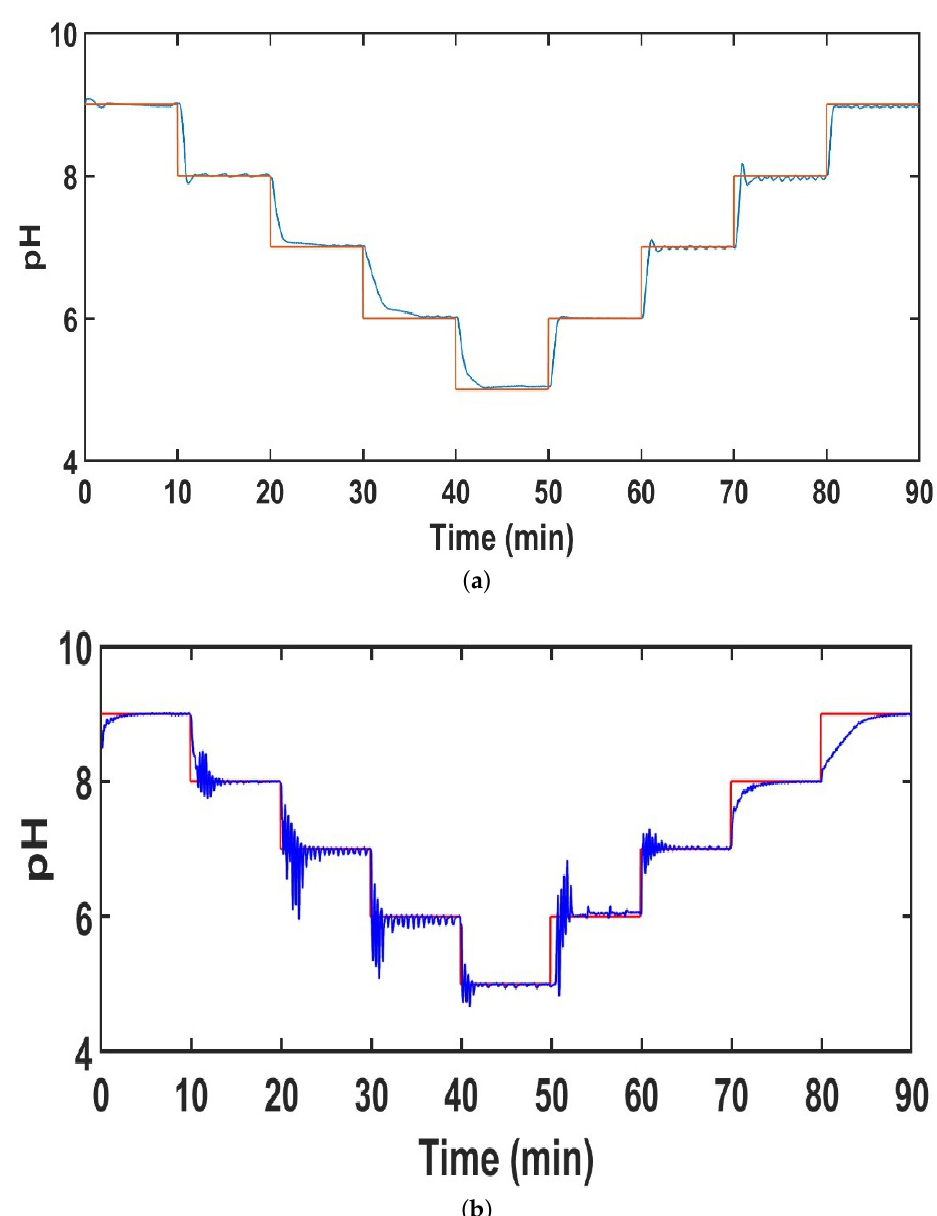
Figure 9. The figure shows the result of the pH control for simulated and real processes, respectively, by master–slave synchronization, in a stirred tank with a volume of 1500 L for scaled industrial pro- cess. ( a ) pH reference and pH measured for simulation, ( b ) pH reference and pH measured for industrial-scaled